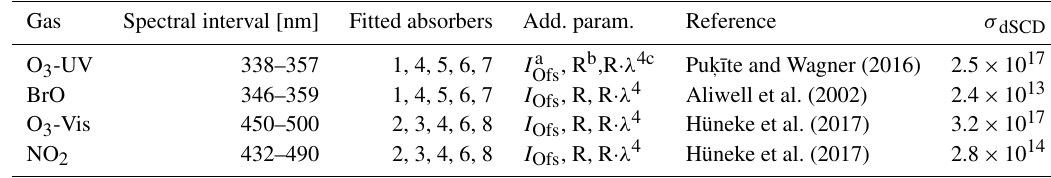
Table 1. DOAS spectral analysis details for the various trace gases and their spectral fitting intervals. Refer to Table 2 for the corresponding fitted absorbers. The σ dSCD values are typical errors in units of molecules per square centimeter. Gas Spectral interval [nm] Fitted absorbers Add. param. O 3 -UV